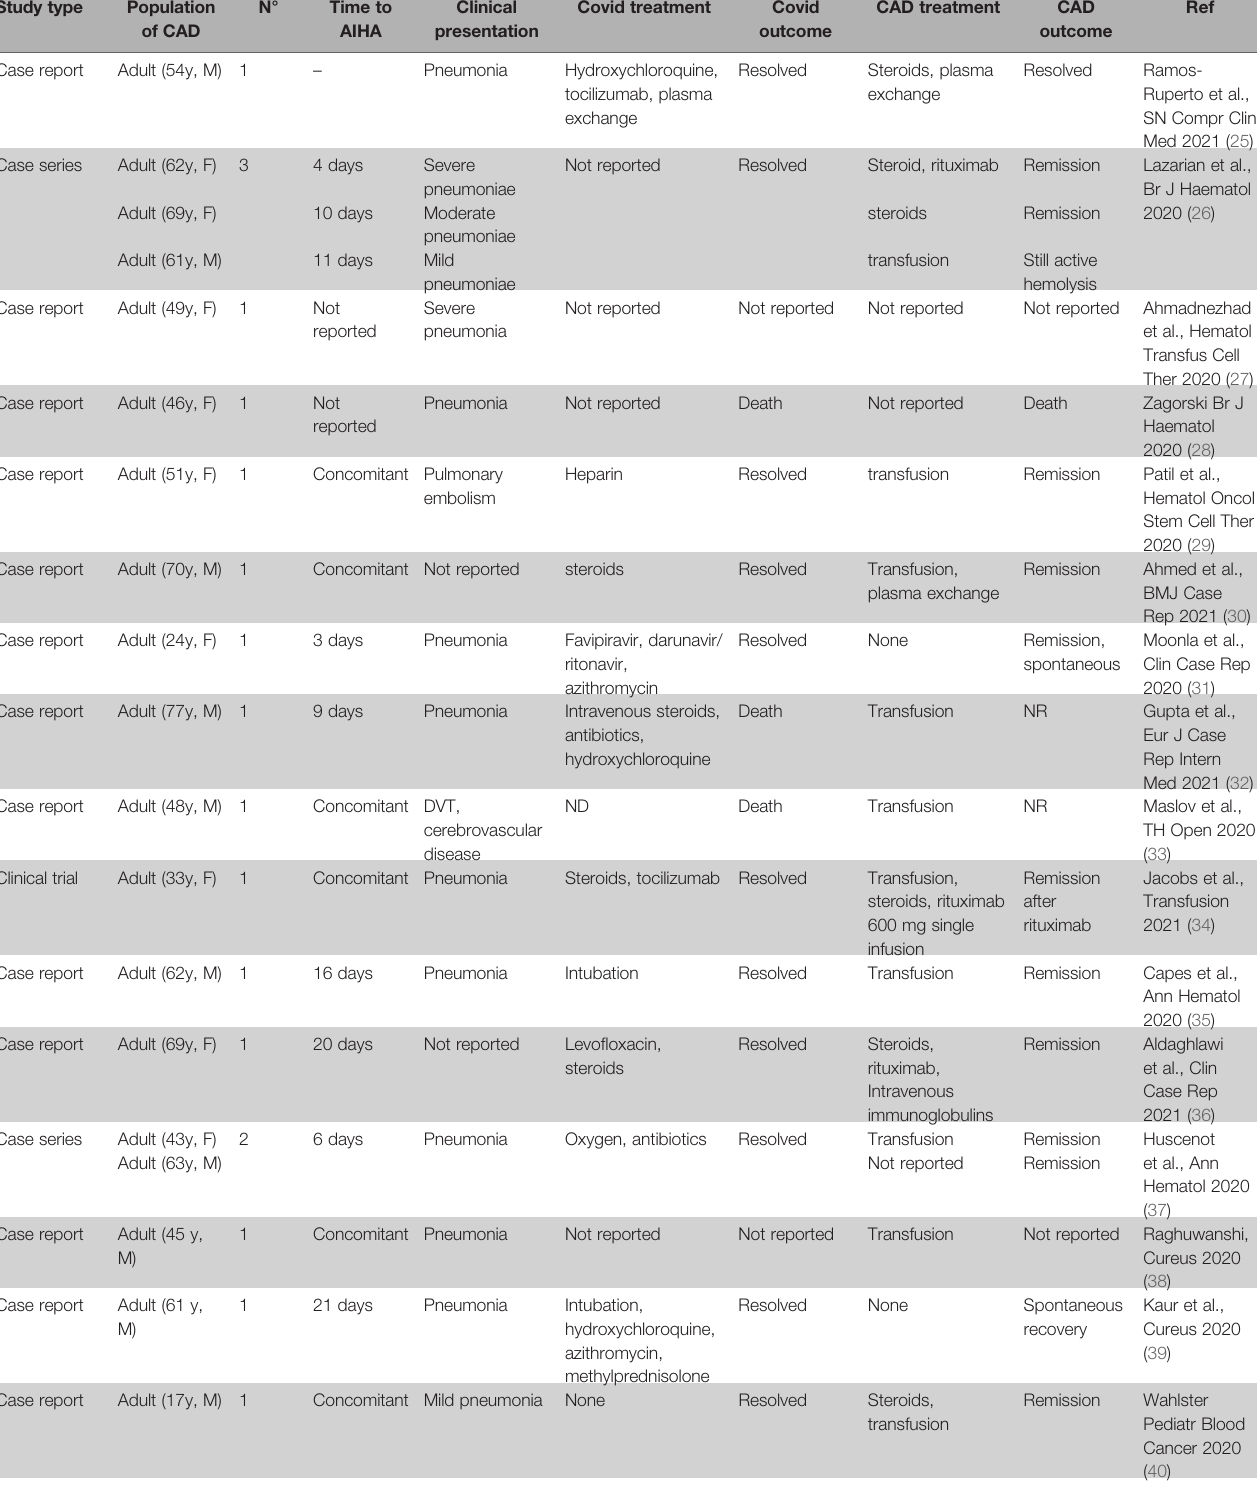
TABLE 3 | Hemolytic fl ares in patients with cold agglutinin disease (CAD) and warm autoimmune hemolytic anemia (wAIHA) during COVID-19